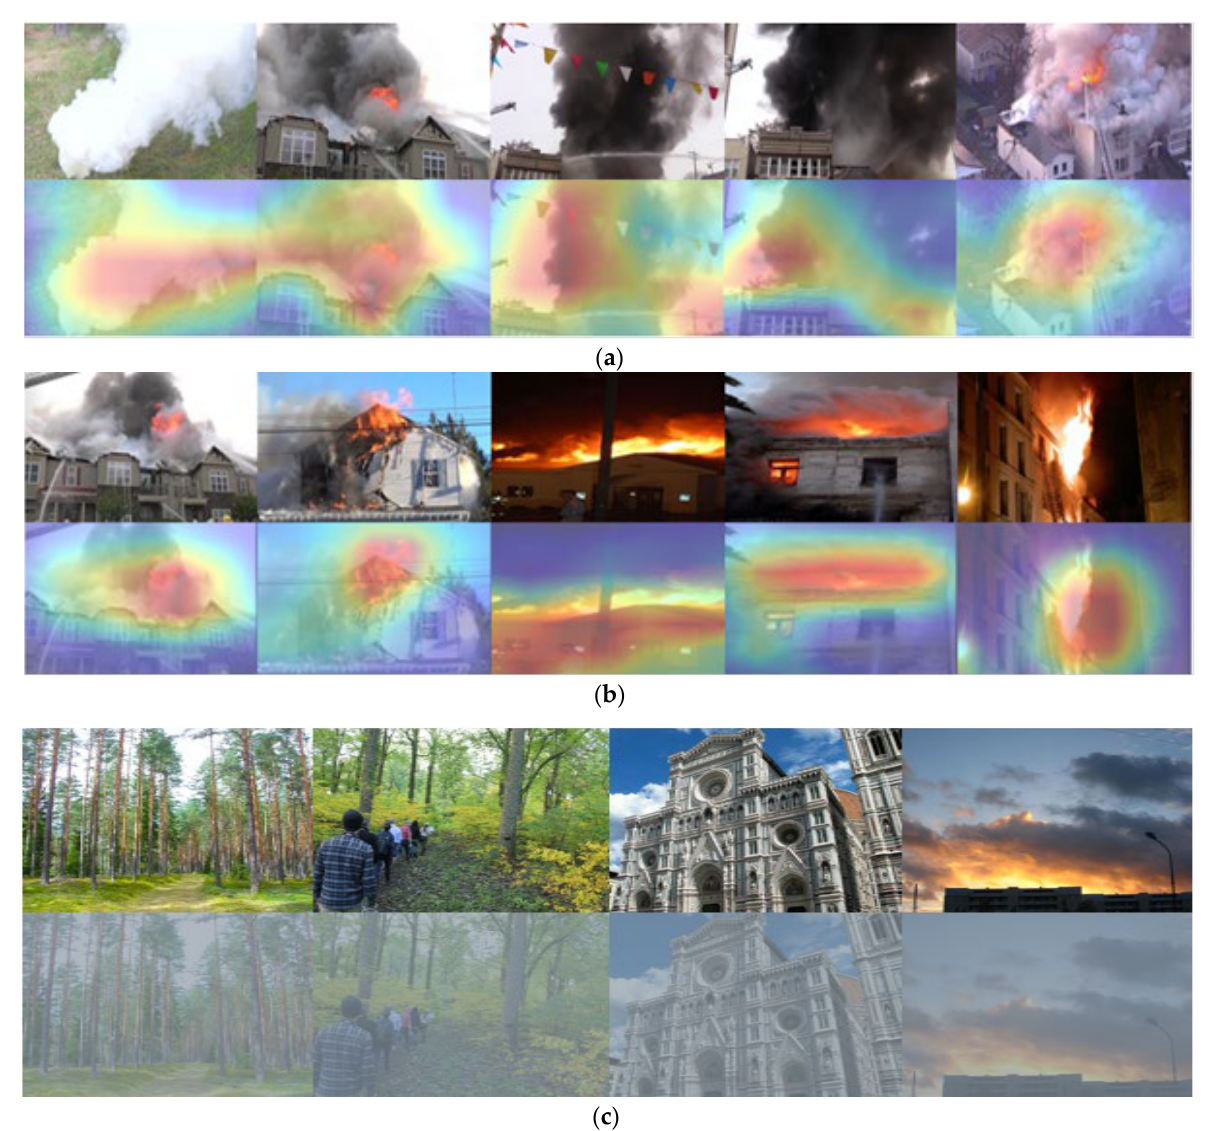
Figure 6. Results of attention feature map using CapsNet for fire classification: ( a ) smoke classification results, (b ) fire classification results, and ( c ) negative image results.